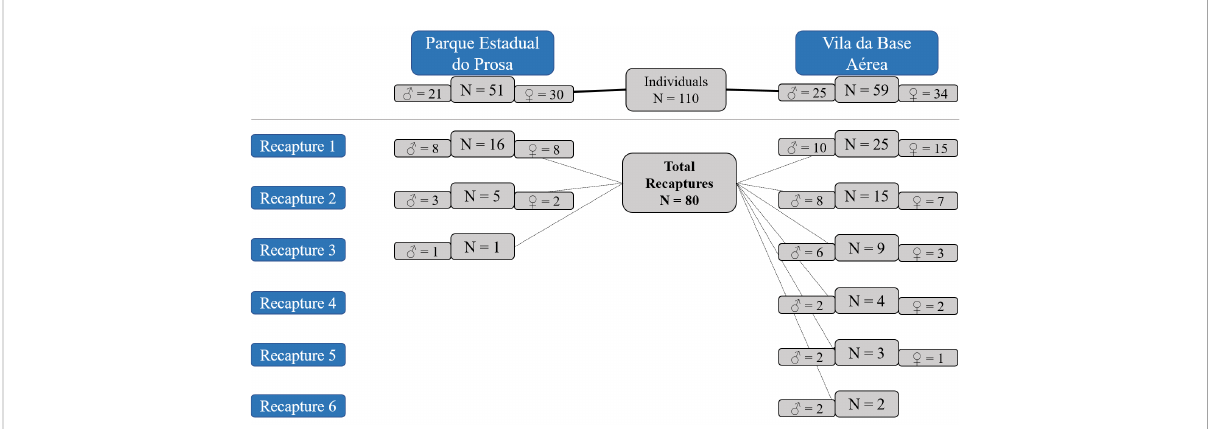
FIGURE 4 Recapture events of South American coatis ( Nasua nasua ) from the conservation unit “ Parque Estadual do Prosa ” (PEP) and the residential area “ Vila da Base Ae ́ rea ” (VBA) from March 2018 to April